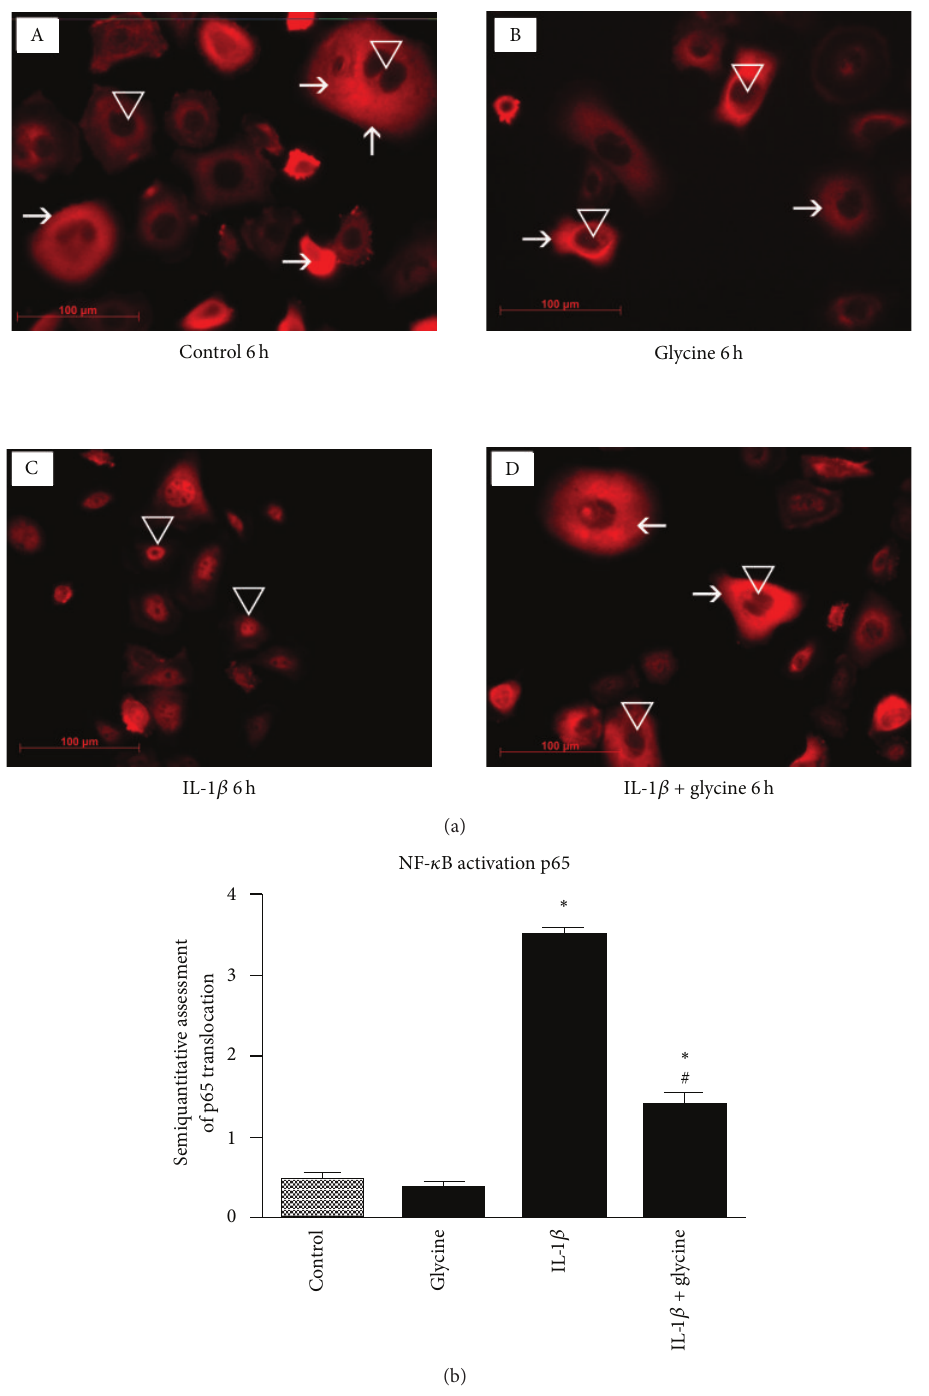
Figure 4: Effects of IL-1 𝛽 and/or glycine on NF 𝜅 B signaling. (a) Immune fluorescence staining of NF 𝜅 B signaling protein p65 of cells (A), glycine (B), IL-1 𝛽 (C), and IL-1 𝛽 + glycine (D) treated human gingival keratinocytes. The photographs demonstrate a localization of p65 protein primarily in the cell cytoplasm in untreated cells. Untreated controls (A) and glycine treated cells (B) did not affect p65 expression. Following the induction of inflammation by IL-1 𝛽 administration, NF 𝜅 B pathway was activated as demonstrated by translocation of p65 proteintothecellnucleus(C).Theadditionofglycinetotheinflammatorycellculturemediumreducedtheobservedp65proteintranslocation (D). (b) Semiquantitative assessment of p65 protein translocation in human gingival keratinocytes following administration of IL-1 𝛽 in combination with and without glycine. ∗ 𝑃 < 0.05 difference between treated and control groups following ANOVA analysis; # 𝑃 < 0.05 difference between IL-1 𝛽 and IL-1 𝛽 + glycine treated